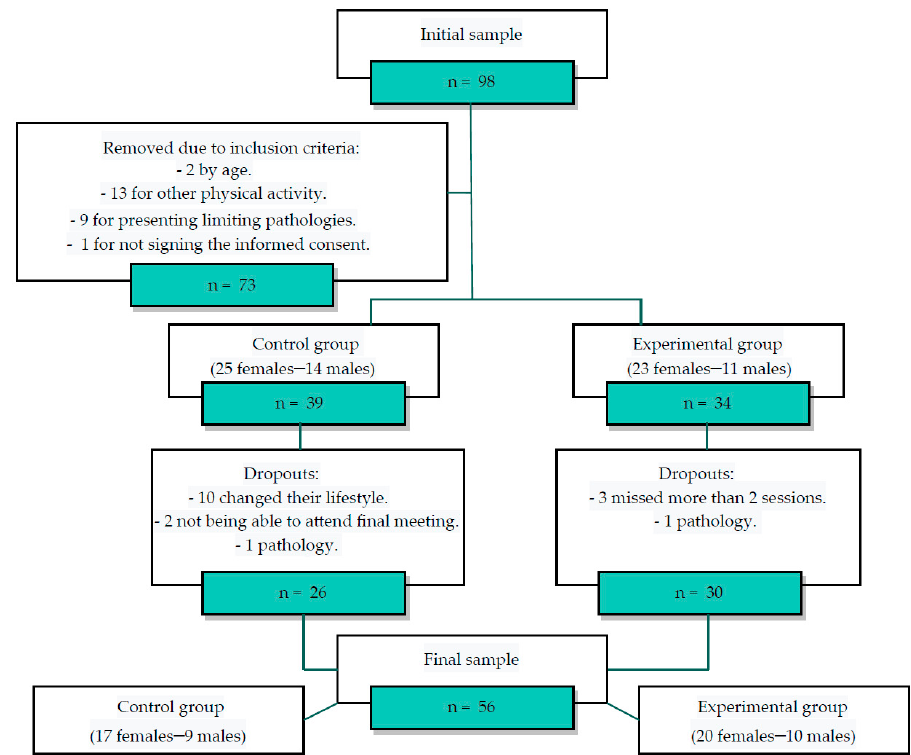
Figure 1. Sample selection flowchart.